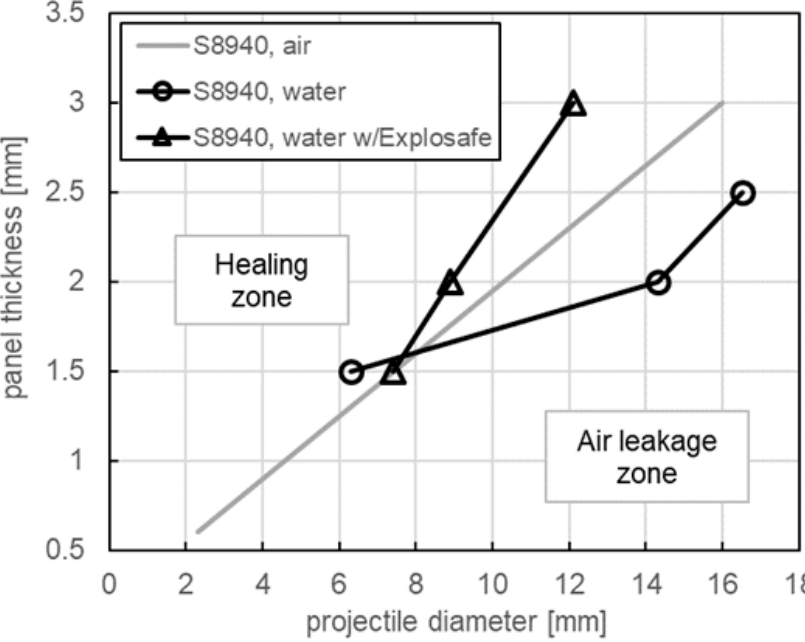
Figure 12. Comparison of self-healing results of ionomeric panels with and without water and Explosafe ® .